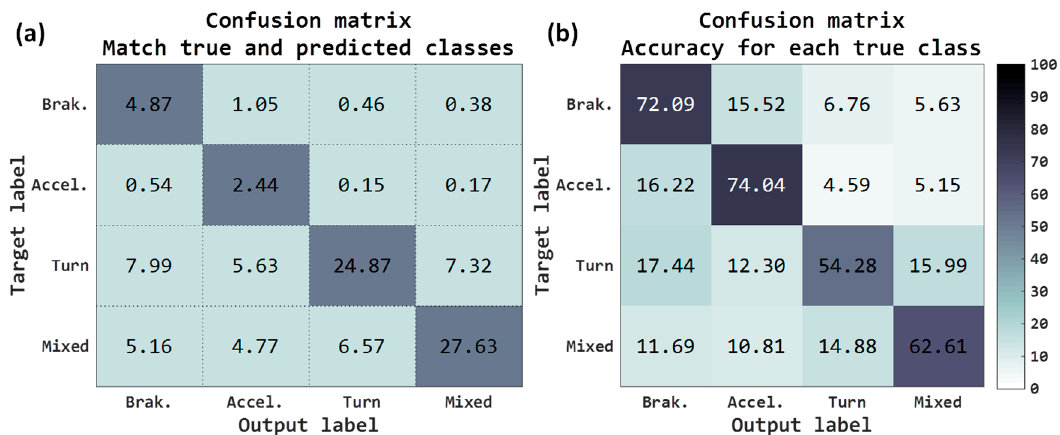
Figure 8. Confusion matrix on raw accelerometers tests removing gravity: ( a ) according to the number of tested maneuvers, ( b ) according to the type of maneuver.